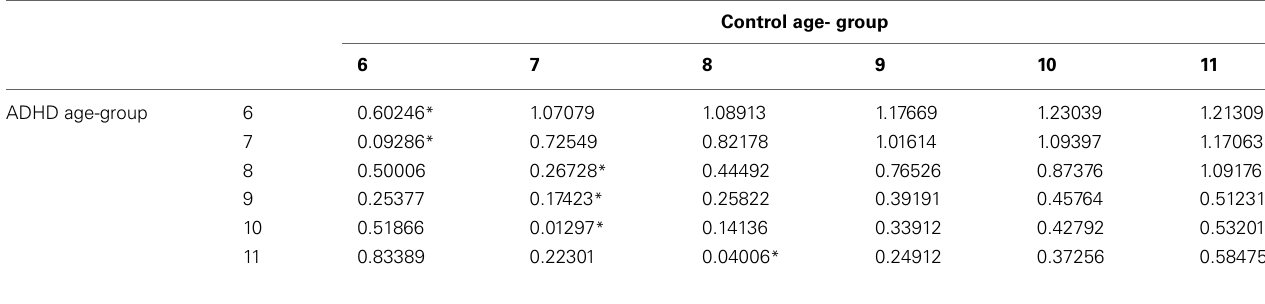
Table B2 | ADHD and control group with the minimal difference in the timing parameter, using Cohen’s D measure.